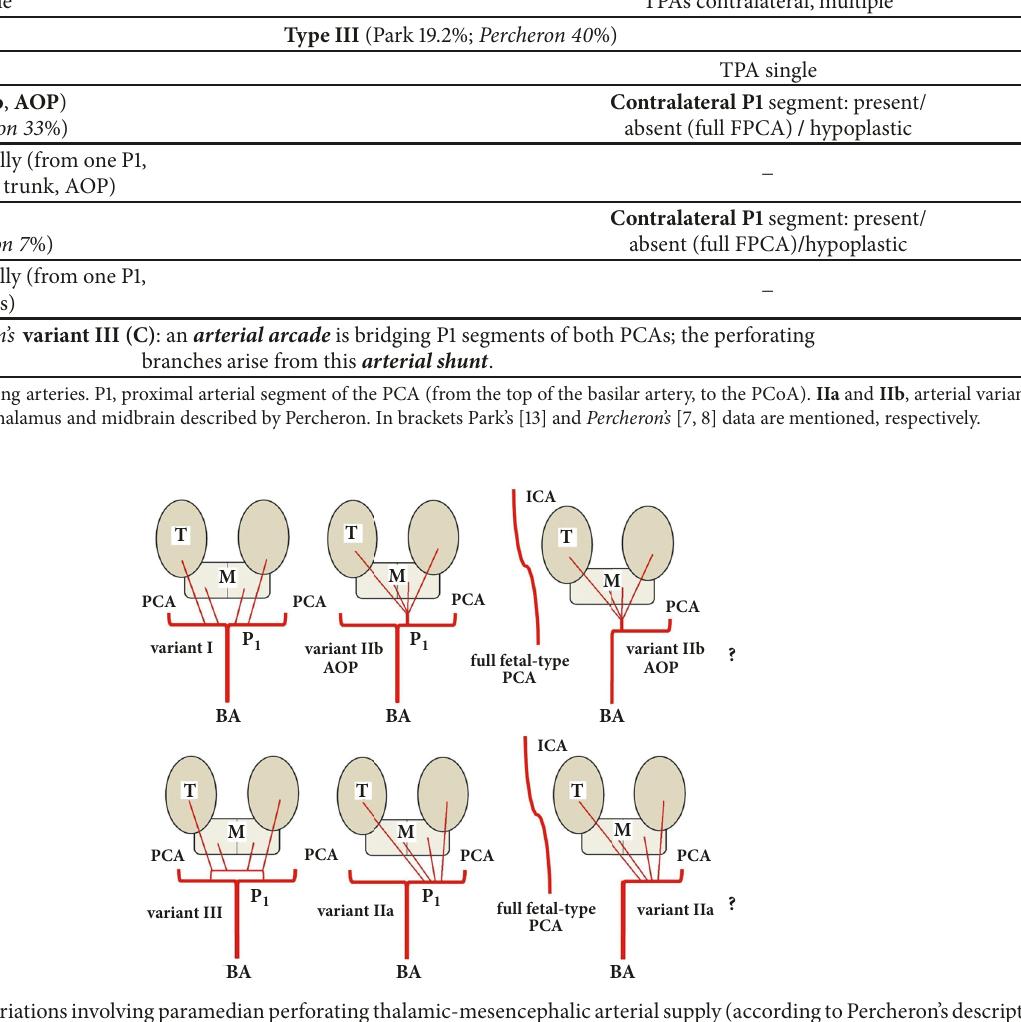
of the posterior circulation in 10.7% specimens, but not the association of AOP with FPCA